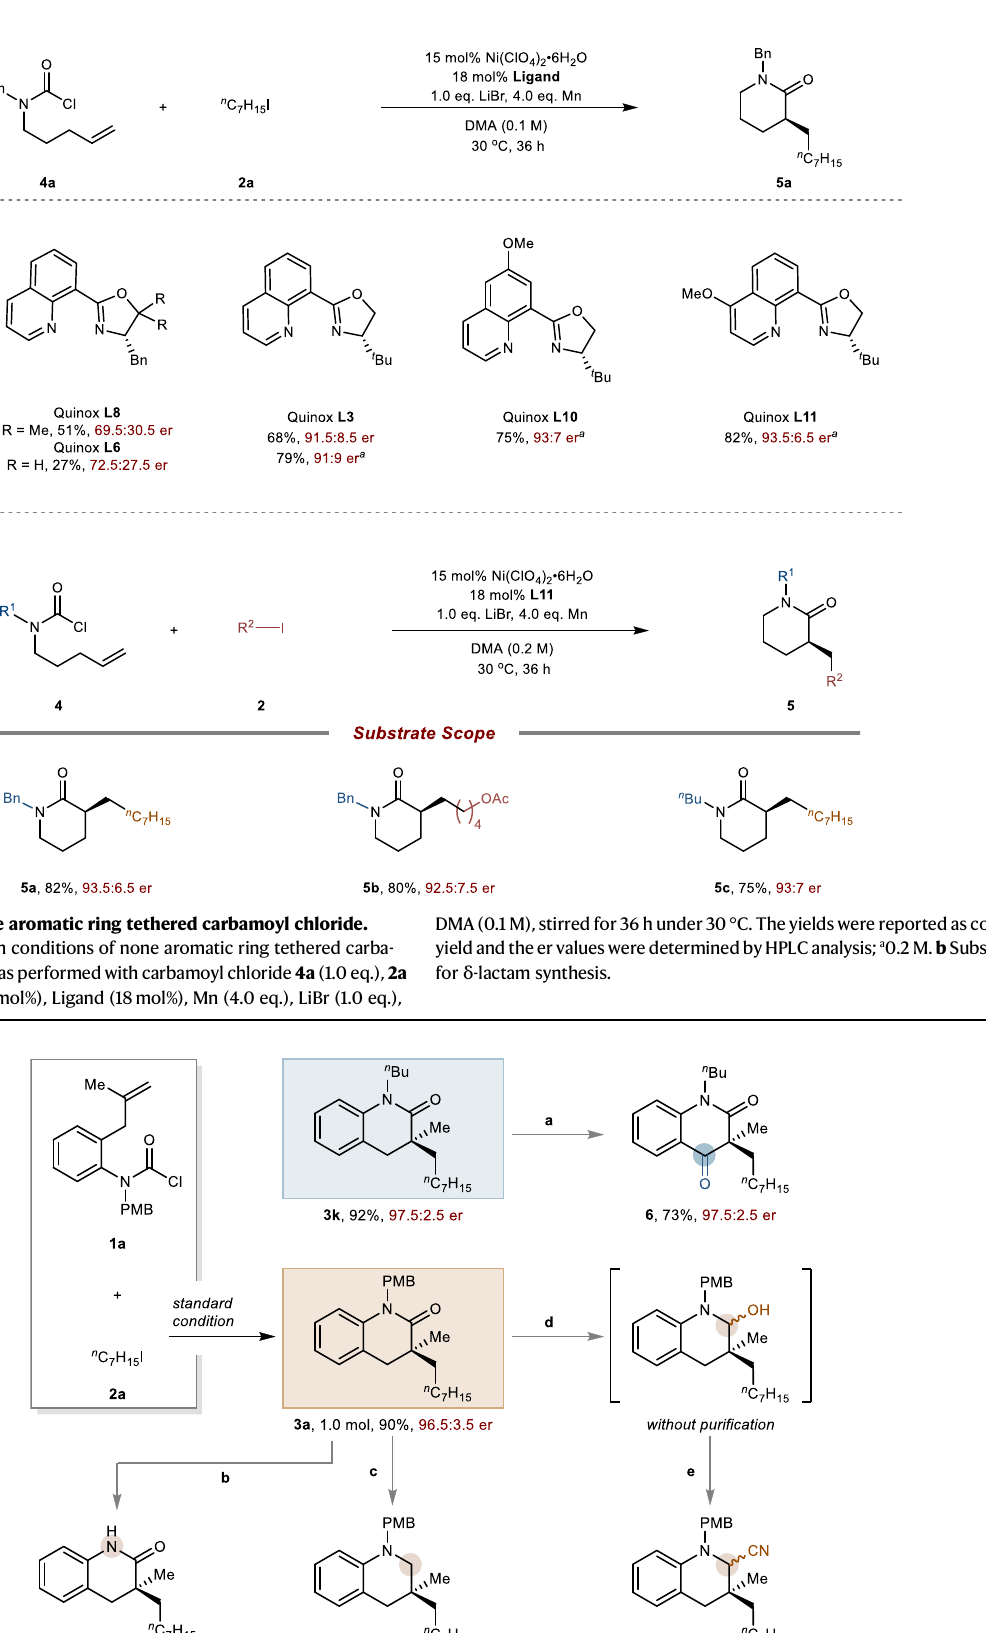
Fig.6|Synthetictransformationsofquinolinoneproducts. Reactionconditions: a 4.0 eq. CAN, MeCN/H 2 O (0.03M), r.t.; b TFA (0.1M), DCM (0.1M), re fl ux; c 2.0 eq.